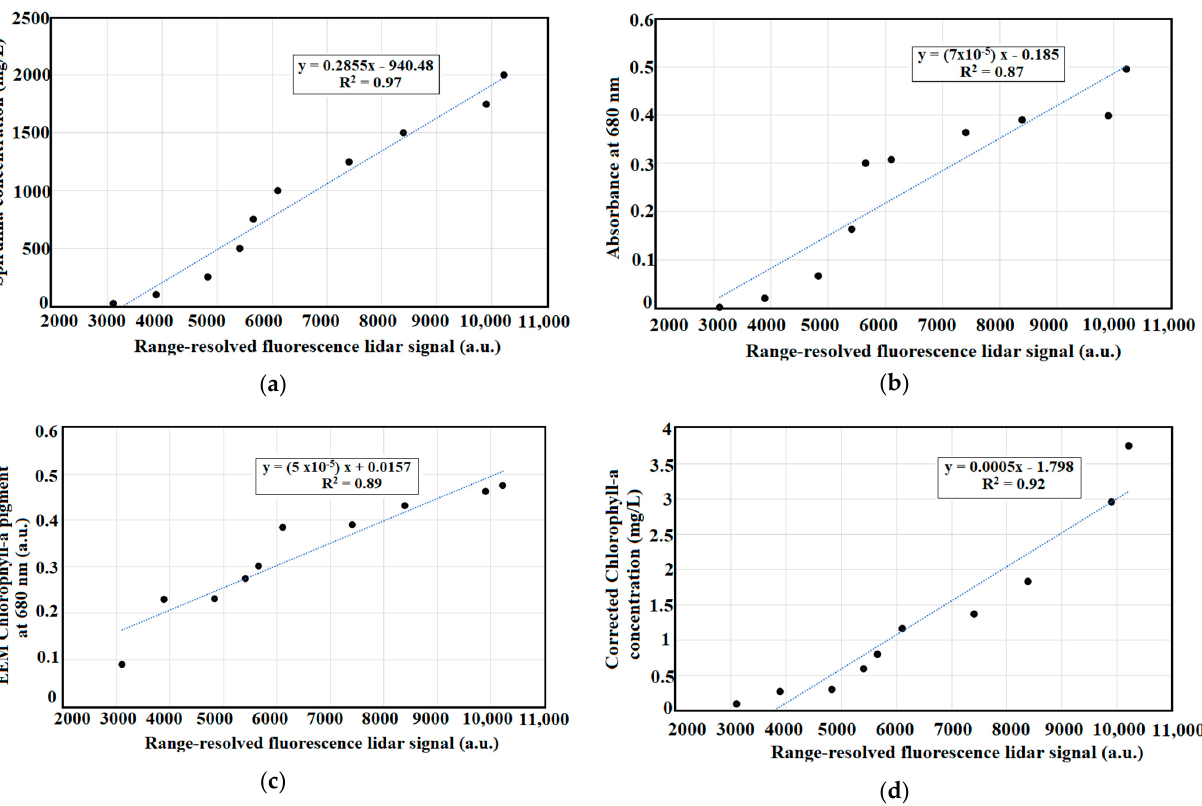
Figure 8. Scatter plots of range-resolved fluorescence lidar peak intensity and: ( a ) Spirulina concen- tration, ( b ) absorbance at 680 nm, ( c ) EEM chlorophyll-a pigment, and ( d ) corrected chlorophyll-a concentration.